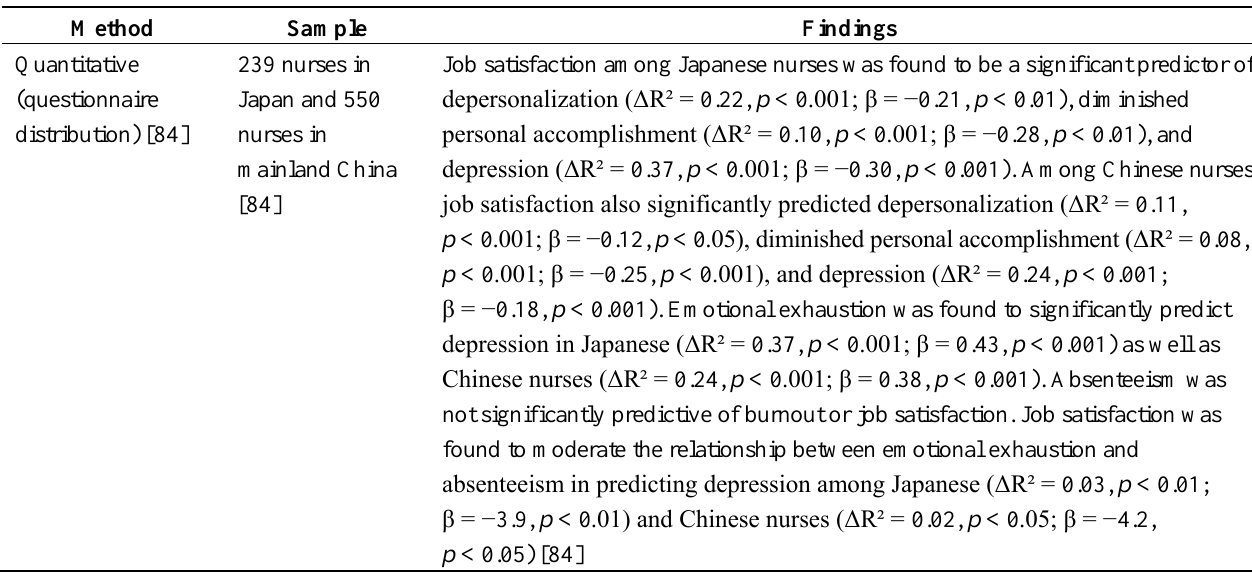
Table 9. Method, sample and findings of identified articles.